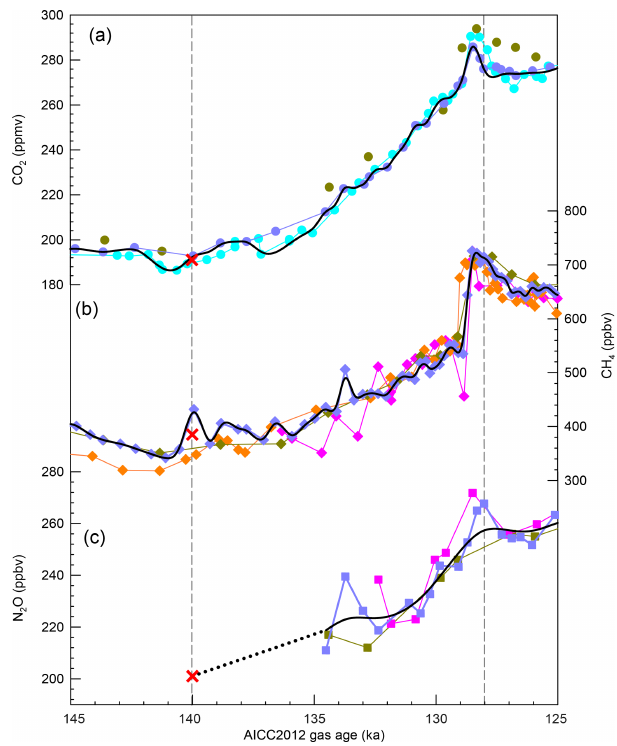
Figure 2. Atmospheric greenhouse gas concentrations: atmospheric trace gases through the penultimate deglaciation from Antarctic ice cores displayed on the AICC2012 chronology (Bazin et al., 2013; Veres et al., 2013) and the spline that should be used to force the transient simulations (solid and dotted black lines; Köhler et al., 2017a). (a) Atmospheric CO 2 concentrations from EDC (turquoise and blue) (Lourantou et al., 2010; Schneider et al., 2013) and TALDICE (green) (Schneider et al., 2013). (b) Atmospheric CH 4 concentration from EDC (Loulergue et al., 2008) (blue), Vostok (Pe- tit et al., 1999) (orange), TALDICE (Buiron et al., 2011) (green) and EDML (Capron et al., 2010) (pink). (c) Atmospheric N 2 O con- centration from EDC (Flückiger et al., 2002) (blue), EDML (Schilt et al., 2010) (pink) and TALDICE (Schilt et al., 2010) (green). Due to in situ production within the ice sheet, no accurate N 2 O mea- surements are available beyond 134.5ka. Between 140 and 134.5ka N 2 O should increase linearly from 201 to 218.74ppb (dashed black line). Red crosses indicate the 140ka spin-up values for CO 2 , CH 4 and N 2 O concentrations (i.e. 191ppm, 385 and 201ppb, respec-